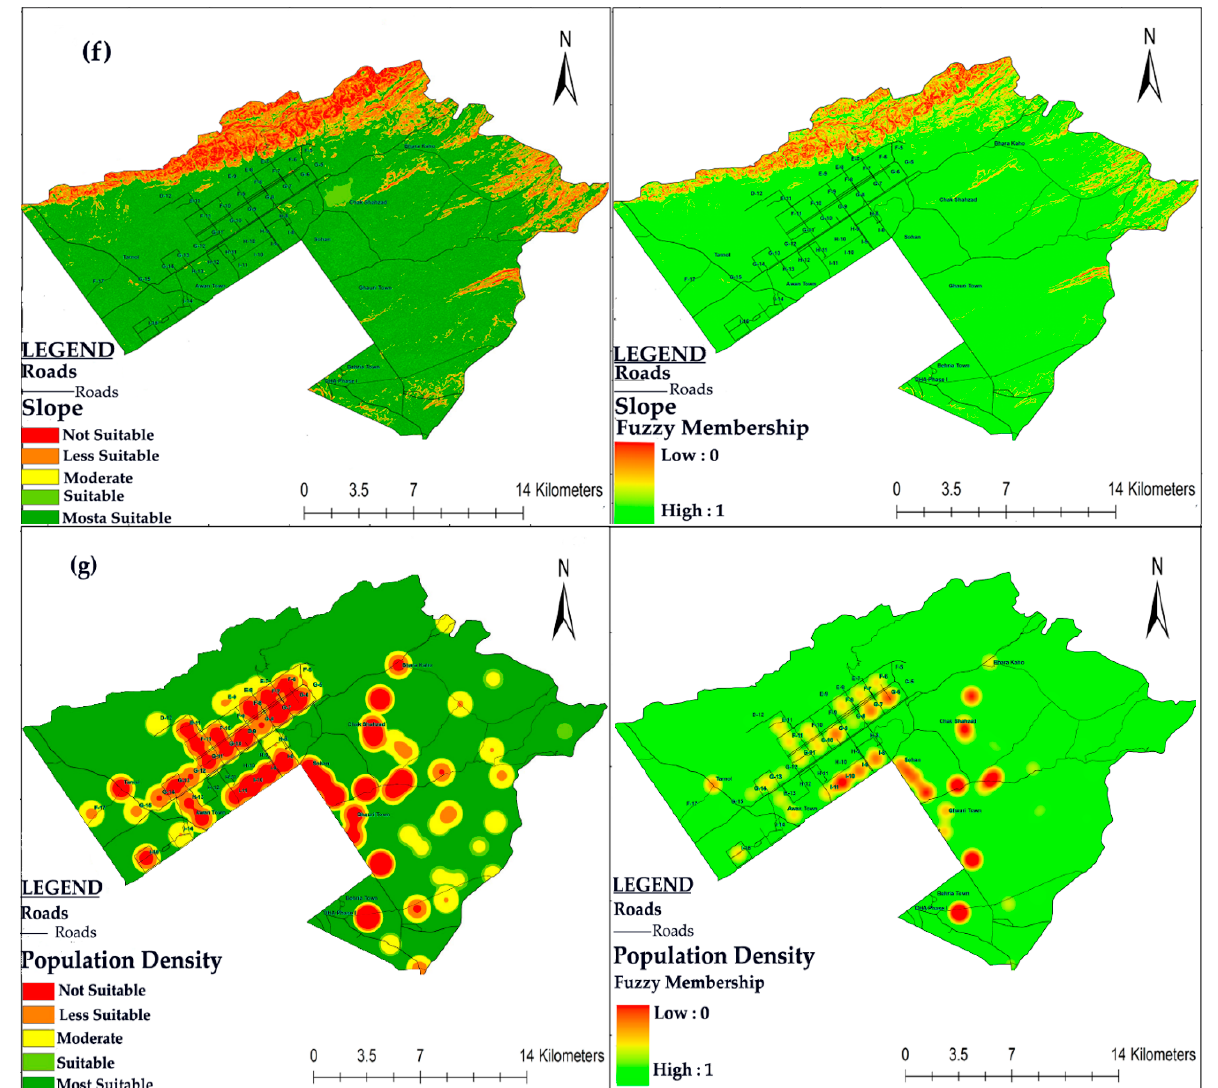
Figure 7. Factor map for fuzzy logic ( right ) and AHP ( left ) including ( a ) LULC ( b ) soil types ( c ) water table ( d ) elevation ( e ) drainage density ( f ) slope ( g ) population density.